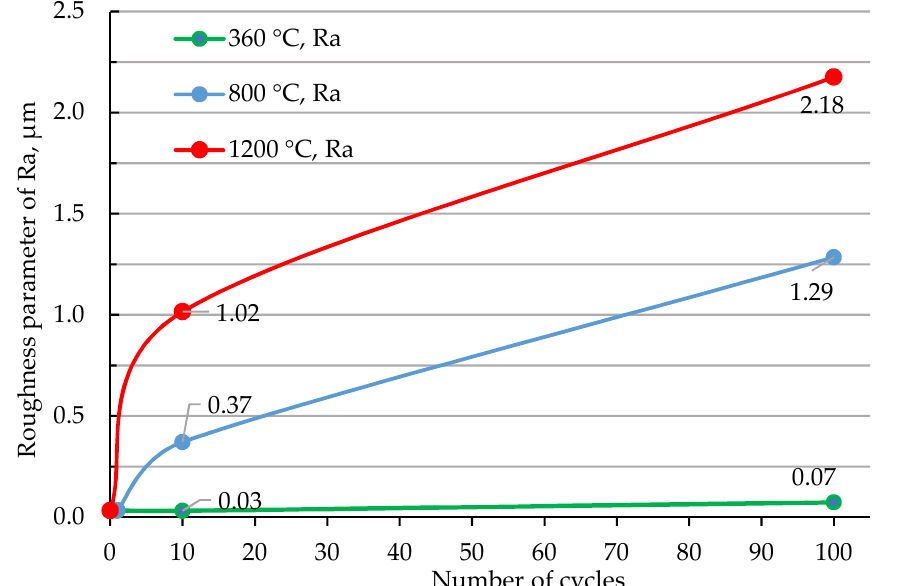
Figure 2. Dependence of the surface roughness parameters of the beryllium samples on the conditions of effect to hydrogen plasma.